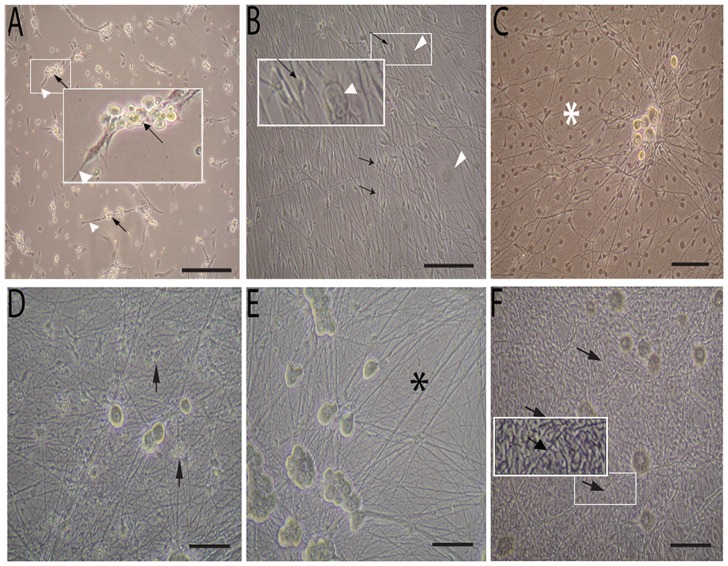
Phase contrast images of DRG purification and myelination.(A) DRG cultures at 24 h before adding antimitotic reagents cocktail, black arrow show DRG neurons, white arrowhead show non-neurons cells; (B) DRG cultures 72 h without high dose antimitotic reagent cocktail treatment, Schwann cell associated with neuritis (arrow) and other big flat non-neuron cells migrated out and grew between neuritis (arrowhead); (C) DRG cultures at 7 day without cocktail treatment, Schwann cell and other non-neuron cell formed a cellular lawn (white star) with DRG neurons sitting on them; (D) DRG cultures 72 h after cocktail treatment, abundant neurites and neurons were observed, dead non-neuron cell debris (black arrow) floating in the medium; (E) DRG cultures at 7 day after cocktail treatment, a pure DRG population without dead non-neuron cells established, single or small cluster of DRG neurons showed typical morphologies with no signs of damage, clean neurites without non-neuron cells (black star); (F) Cocktail treated DRG cultures 14 days after seeding Schwann cells and initiating myelination with ascorbic acid, abundant mature myelin had formed (arrow). Scale bar 50 µm.